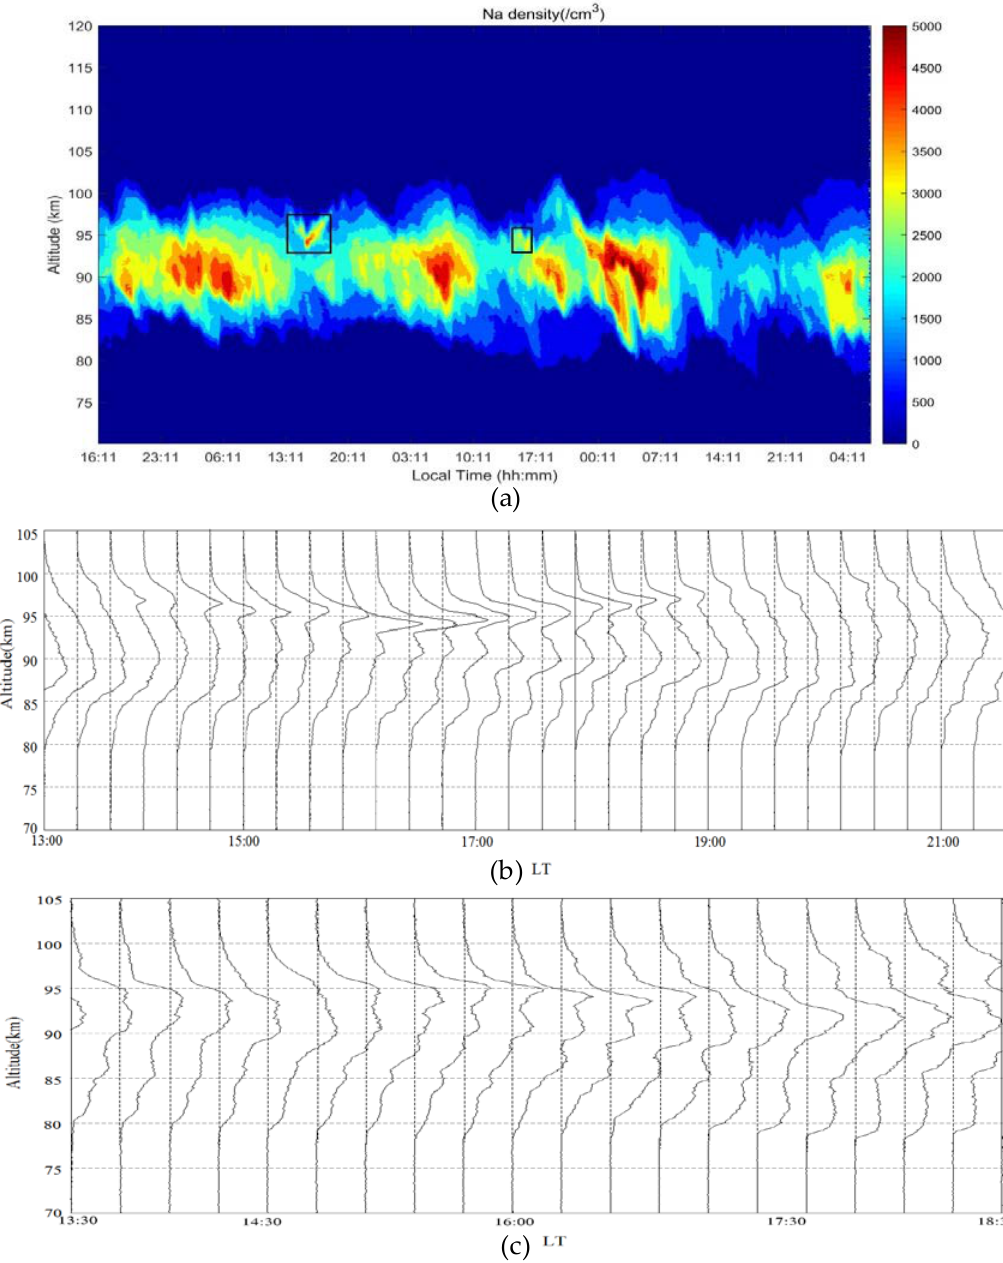
Figure 8. ( a ) The evolution of the density profile 2–5 November 2014. ( b ) The evolution detail of a Nas event at 3 November 2014. ( c ) The evolution detail of a Nas event at 4 November 2014.